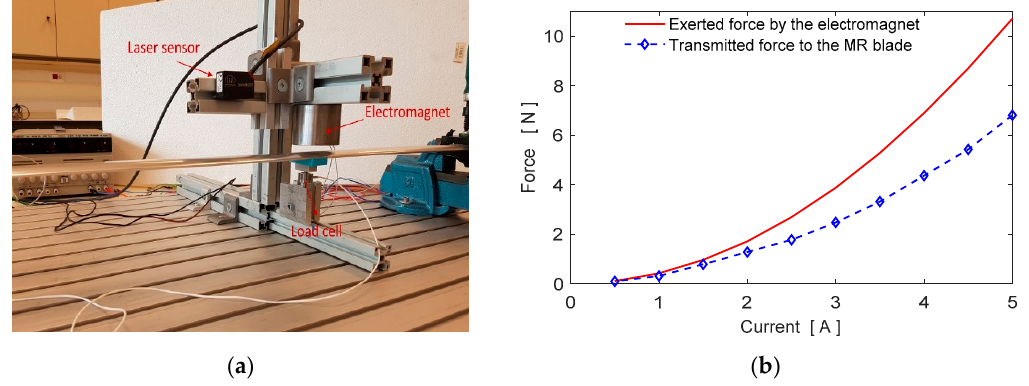
Figure 7. Force measurements ( a ) Experimental setup, ( b ) Variation of the electromagnetic force and the transmitted force.